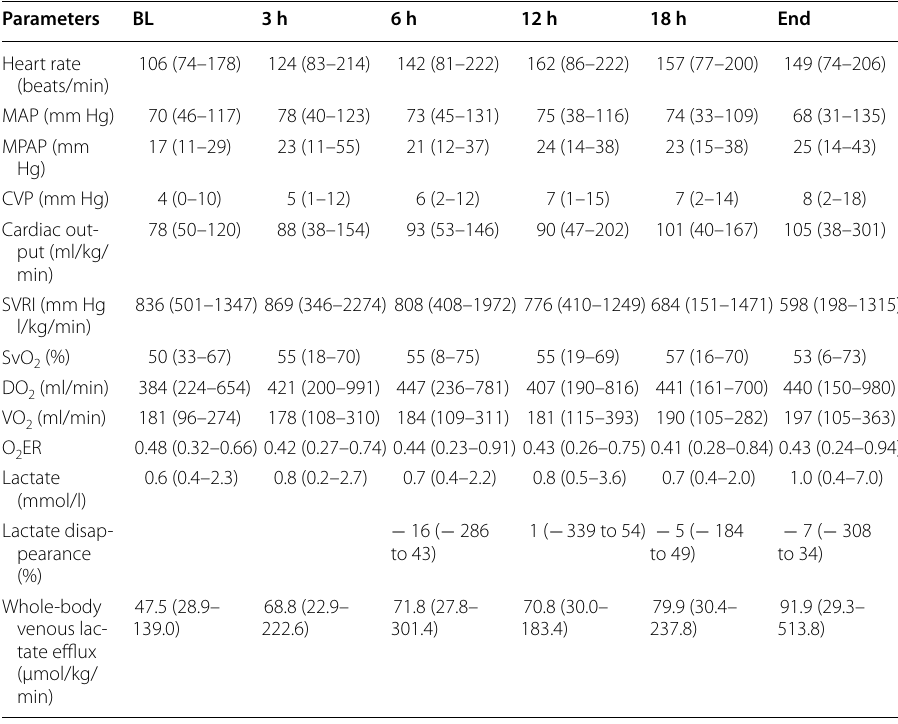
Table 1 Systemic hemodynamics, arterial lactate levels and whole-body venous lactate